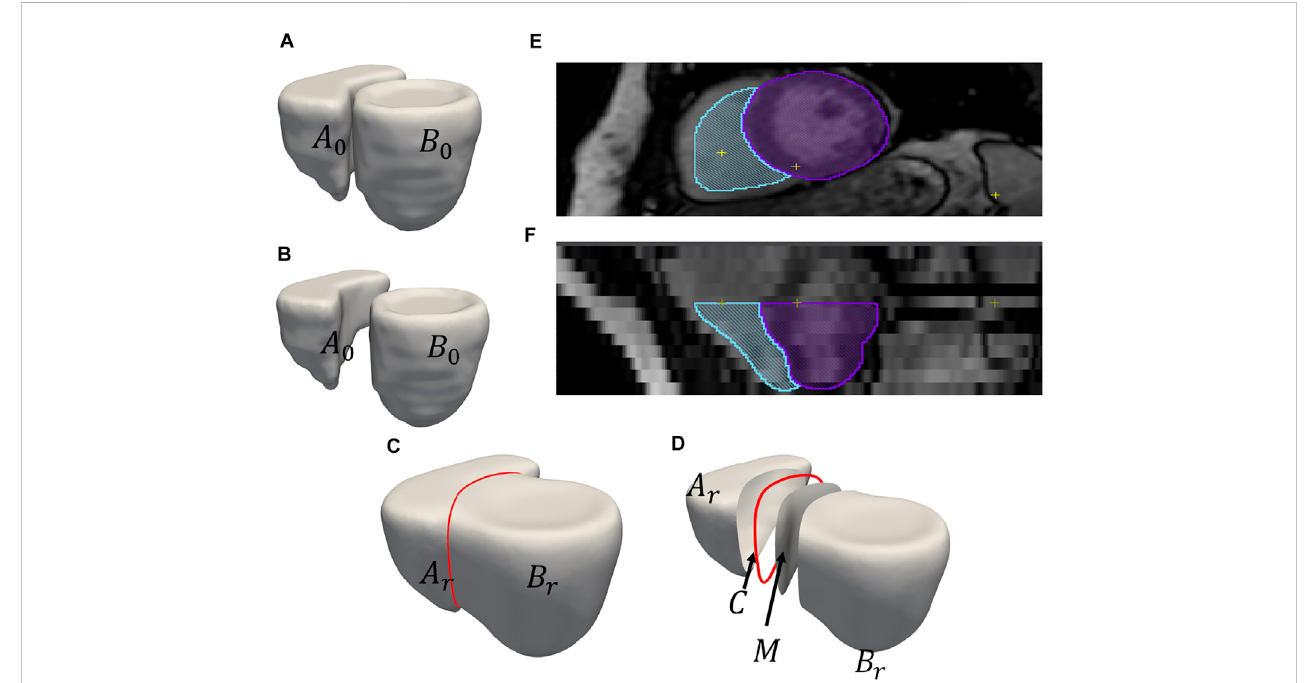
FIGURE 2 An example of output obtained after shared boundary extraction. Meshes representing (A) RV and LVW show that they have a shared boundary surface, and (B) RV and LVW meshes are pried apart. The meshes and contour obtained after shared boundary extraction (C) RV, LVW, shared surface and contour (D) all outputs pried apart for visualization. The red color indicates the contour. The image shows 2D slices of the endocardial segmentationfor the RV (blue) and epicardial segmentation for the LV (violet) at end-diastole in the (E) axial view and (F) coronal